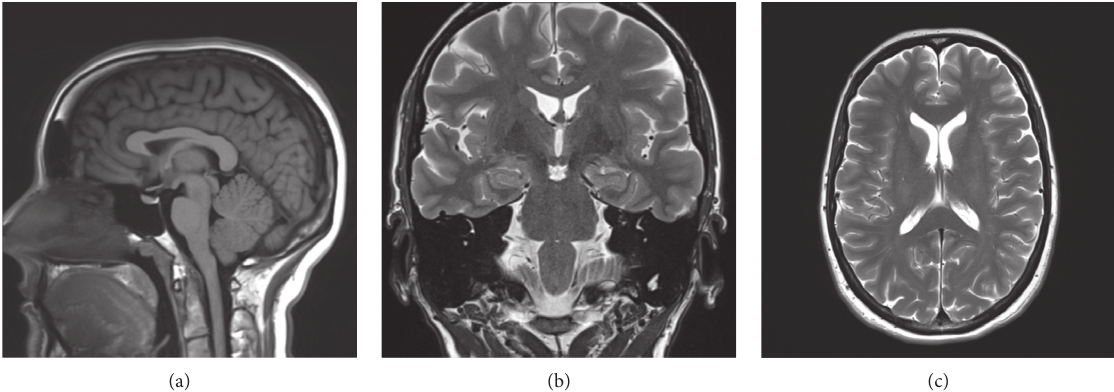
Figure 1: Brain MRI scans: Patient30: sagittal T1 of a 30-year-old female patient [20]. Patient50: coronal T2 of a 50-year-old female